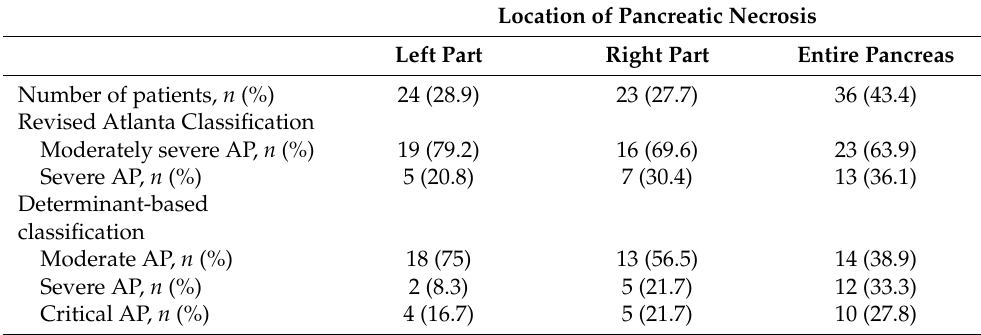
Table 4. Clinical outcome by the location of pancreatic